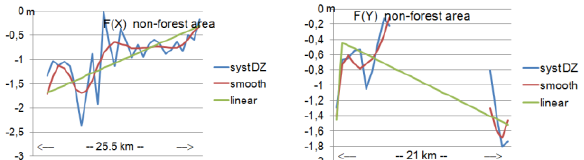
Fig. 15: Systematic height errors of WorldDEM as function of X and Y shown as mean for each distance group in blue, smoothened function in red and as linear function in green, only for non-forest